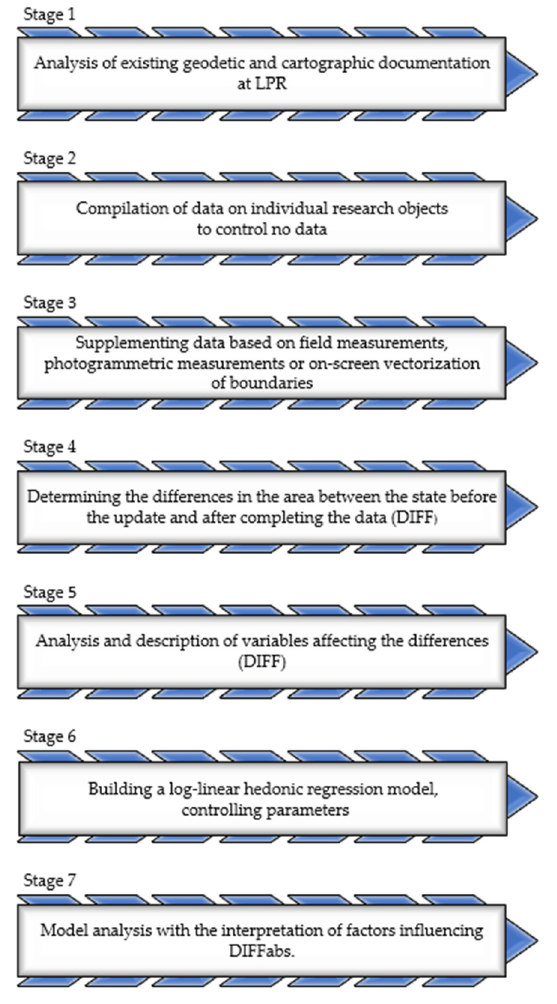
Figure 1. Stages of research. Source: own study.